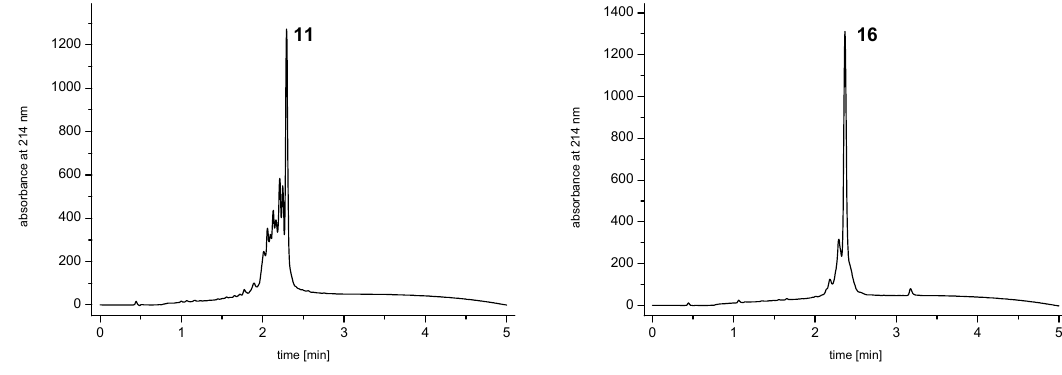
( 11 , left) or PEG -linkers in each possible 1 1